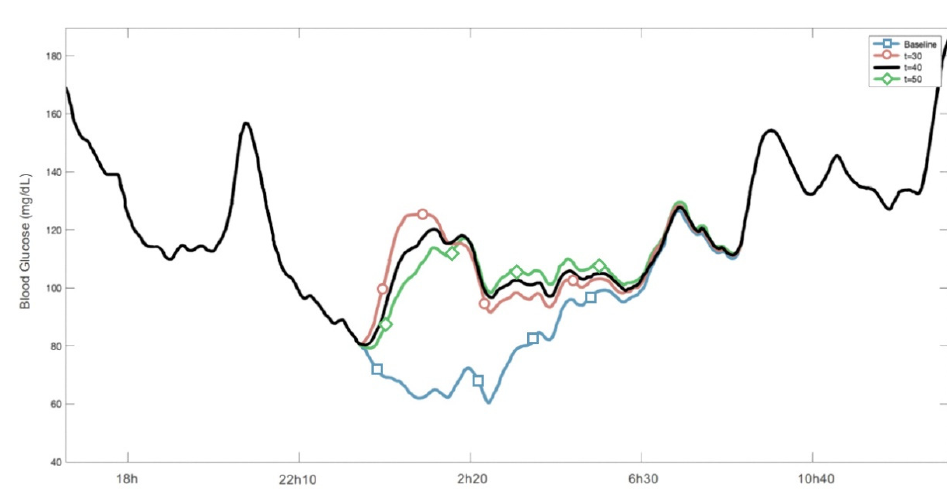
Figure 5. Example of action to prevent a hypoglycemic event with 30 g CHO. In blue: the baseline mg/dL of a given patient during the event. In red, black, and green the mg/dL when 30 g of rescue CHO were ingested with different time constants of absorption.